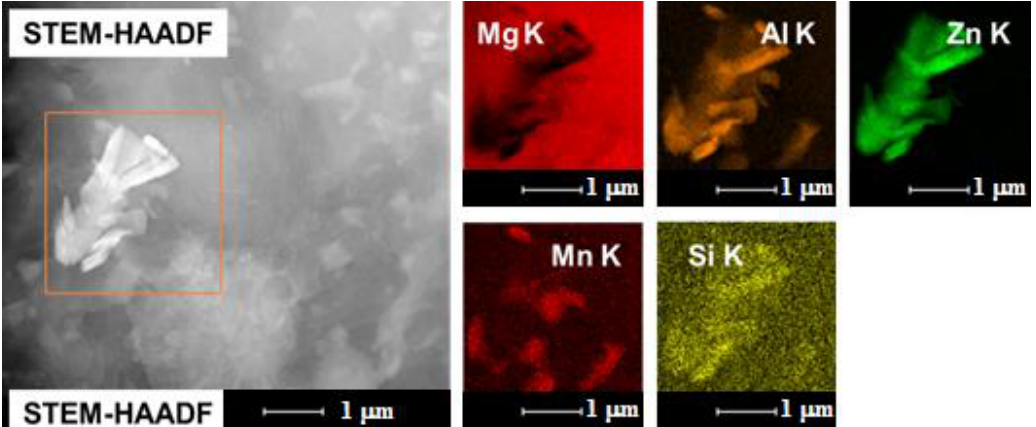
Figure 11. STEM-HAADF image and corresponding elemental maps performed at the marked area of the sample after the first pass.